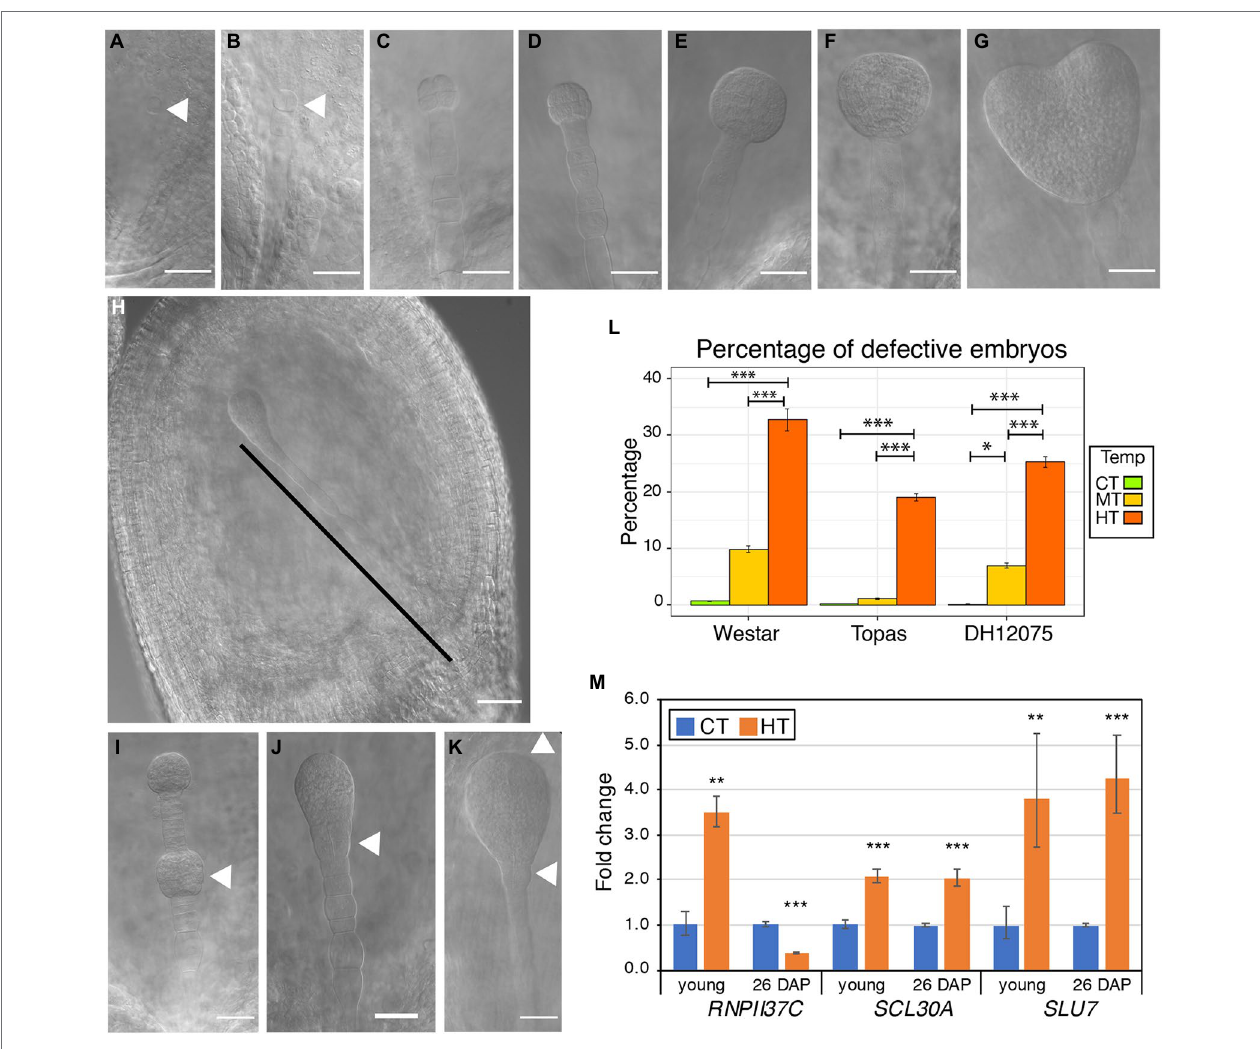
FIGURE 4 | Effects of high temperatures on embryo development. (A–G) Representative photos of embryos of Brassica napus plants grown at CT. The developmental stages of the embryos are one-cell (A) , two-cell (B) , 8-cell (C) , early globular (D) , late globular (E) , transition (F) , and heart (G) . The arrowheads in (A,B) indicate the apical cell and proembryo. (H–K) Range of defective embryos observed in B. napus plants grown at MT and HT between 6 and 8 DAP. (H) Seed containing an embryo with supernumerary suspensor cells. The black line marks the suspensor. (I) Embryo (7 DAP) with cell proliferation in the suspensor, leading to a secondary embryo (arrowhead). (J) Embryo (7 DAP) with cell proliferation in the root pole (arrowhead). (K) Embryo (8 DAP) without initiation of cotyledon primordia and with unstructured root pole (arrowheads). Scale bars represent 50 μ m (A–K) . Uncropped pictures are presented in Supplementary Figure S5 . (L) Graph displaying the percentage of defective embryos in young seeds of Westar, Topas, and DH12075 plants grown at CT (green), MT (yellow), and HT (orange). Error bars represent the 95% CI. Asterisks indicate a statistically significant difference in MT and HT in an ANOVA followed by Tukey’s post hoc test ( * and *** correspond to value of p 0.05 > p > 0.01 and p < 0.001, respectively). (M) Expression analysis by RT-qPCR of BnaRNPII37C , BnaSCL30A , and BnaSLU in Westar young seeds and 26 DAP seeds. The graph displays the fold changes in expression between CT (blue) and HT (orange). Asterisks indicate statistically significant difference in HT in a paired Student’s t -test ( t -test; ** and *** correspond to value of p 0.01 > p > 0.001 and p < 0.001, respectively). Primers and LOC information are presented in Supplementary Table S1